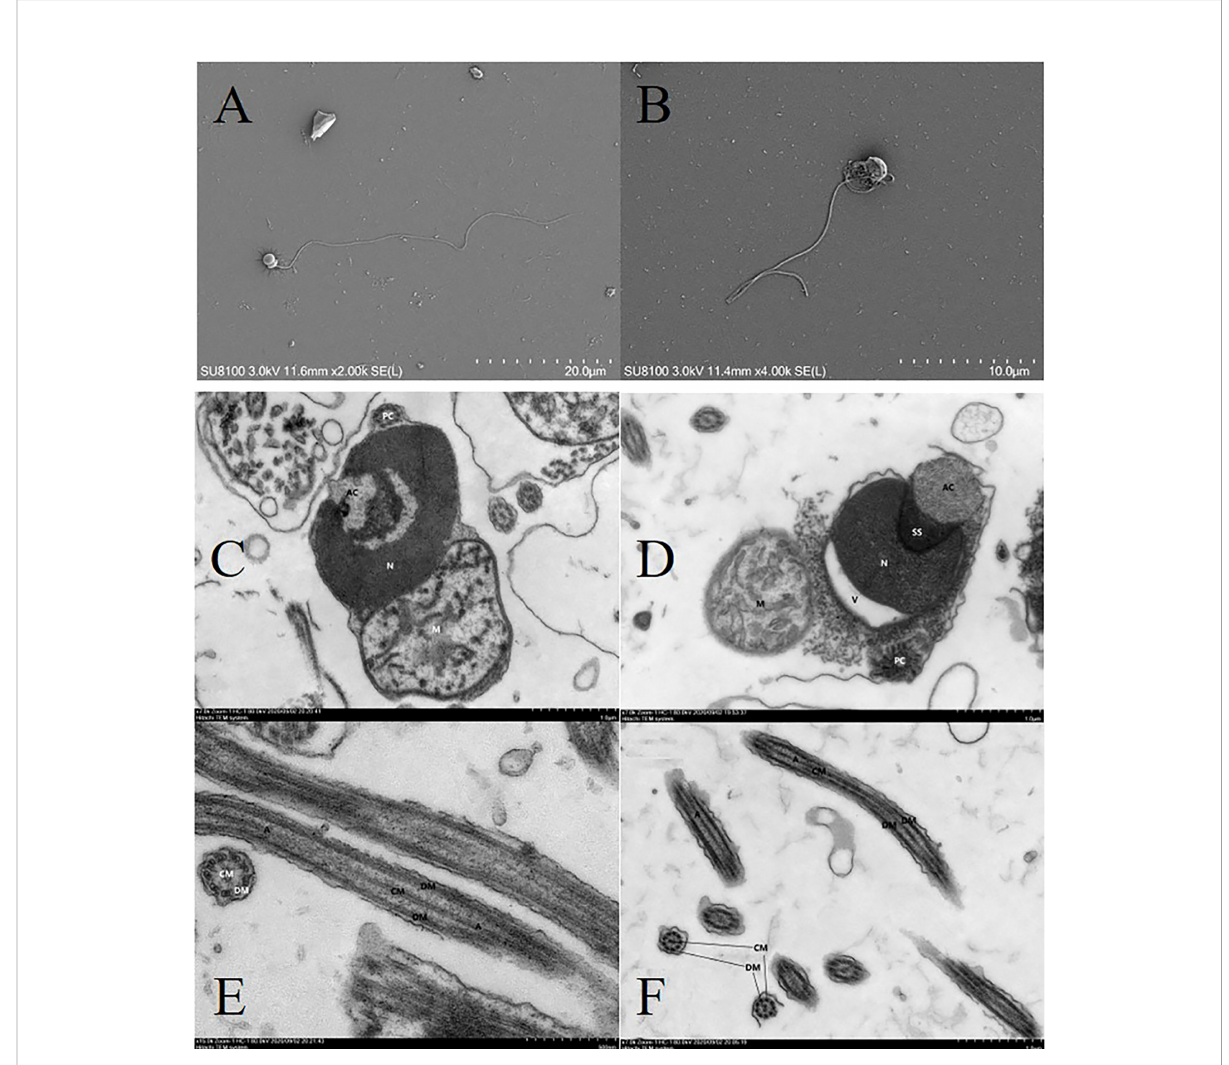
FIGURE 9 Electron micrographs showing structures of fresh and cryopreserved sperm of A. japonicus . SEM results: (A) fresh sperm; (B) cryopreserved sperm. TEM results: (C) head of fresh sperm; (D) head of cryopreserved sperm; (E) tail of fresh sperm; (F) tail of cryopreserved sperm. AC, acrosome; N, nucleus; M, mitochondrion; PC, proximal centriole; SS, subacrosome space; V, vesicle; A, axoneme; CM, central microtubules; DM, double microtubules; SEM, scanning electron